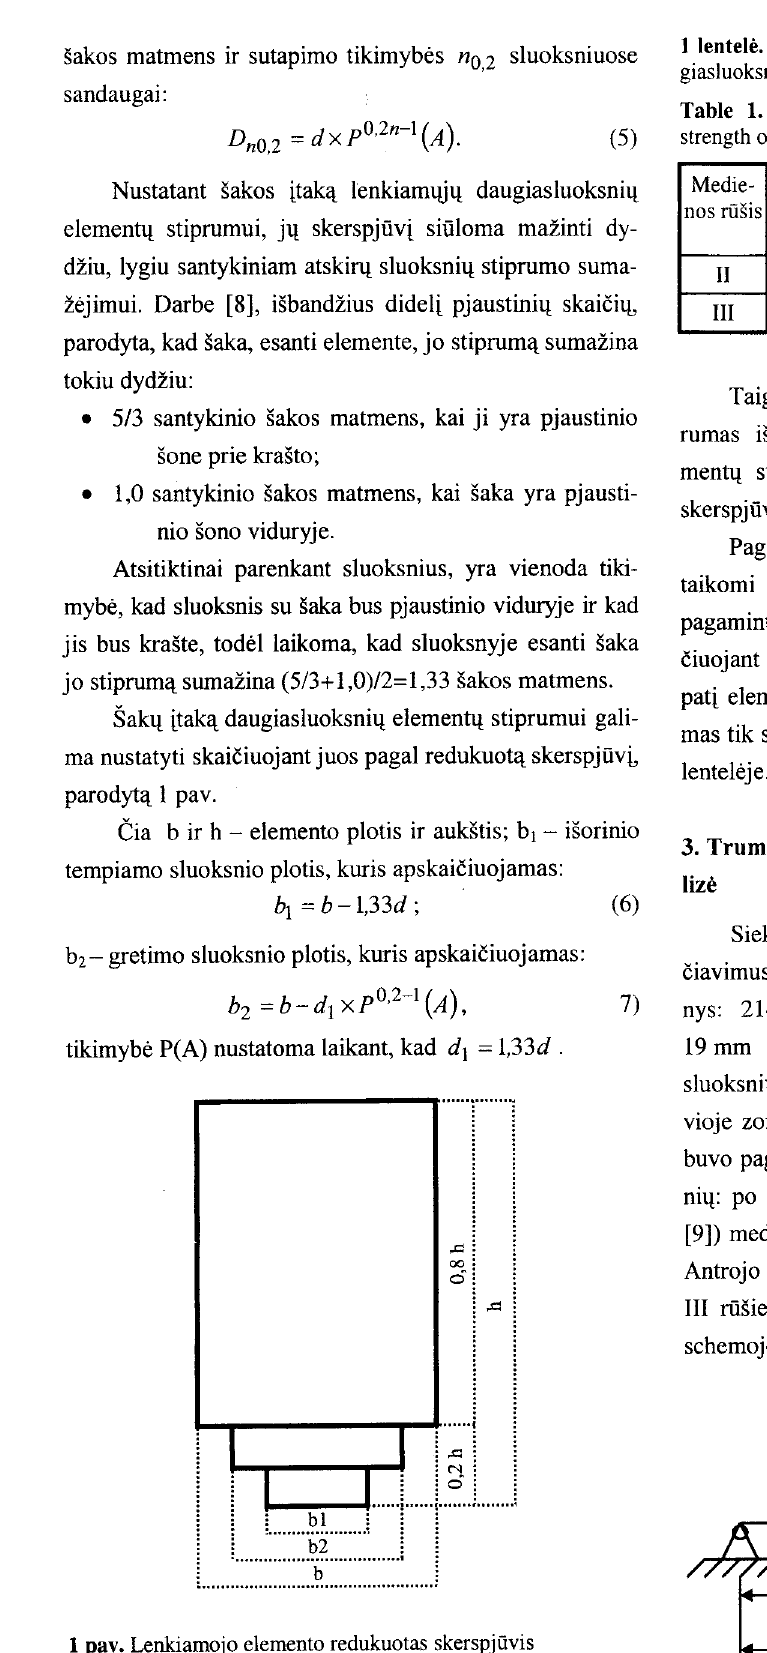
Fig 1. Reduced cross-section of bending member where b and h- the width and height of member;